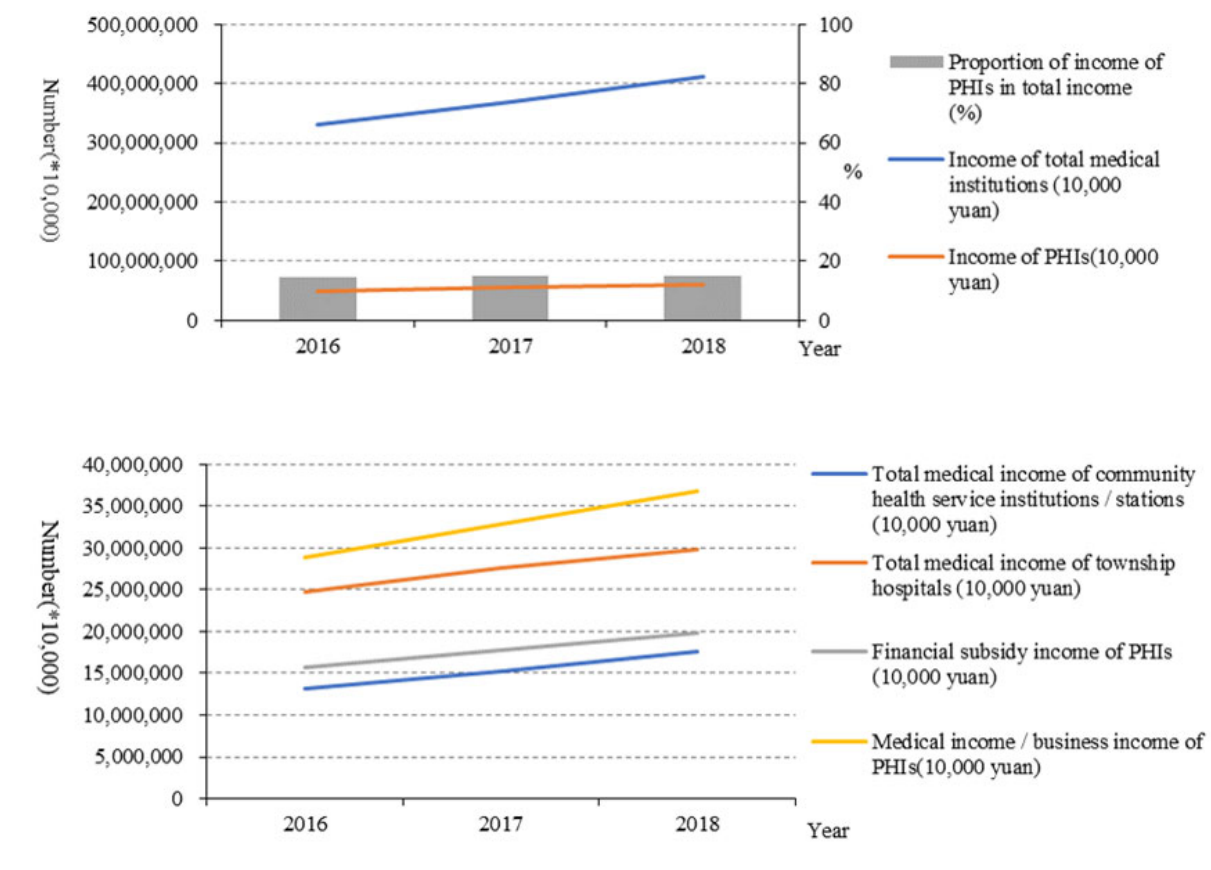
Figure 7. Income of PHIs (10,000 yuan).